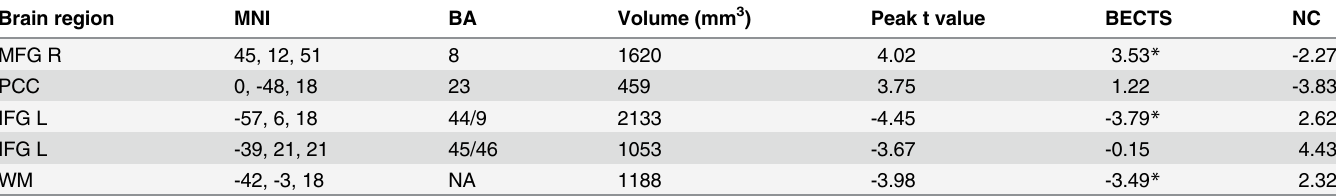
The last two columns show the t value of the corresponding peak voxel within the patient and control group, respectively. Values with an asterisk show that the mean causal effect of the corresponding cluster is signi fi cantly different from zero. BA = Brodmann ’ s area; IFG = inferior frontal gyrus; L = left side; PCC = posterior cingulate cortex, R = right side; MNI = Montreal Neurological Institute coordinate; NC = normal control; WM = white matter;NA, not available.